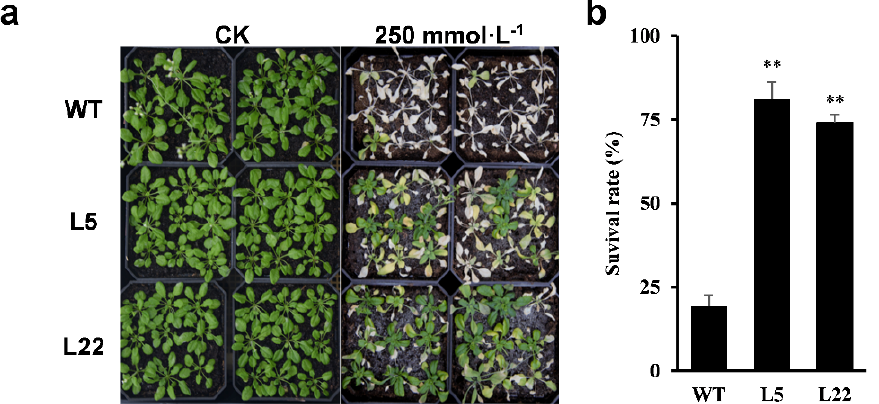
Figure 9. Ectopic expression of IbSAP16 enhanced salinity tolerance in transgenic Arabidopsis . Four- week-old WT and transgenic Arabidopsis seedlings were treated with 250 mmol·L − 1 NaCl solution for 3 weeks. ( a ) Representative image. ( b ) Survival rates of WT and transgenic lines after NaCl treatment. Data are presented as mean ± SE (n = 3). “**” indicates a significant difference from that of WT at p < 0.01, by Student’s t -test.